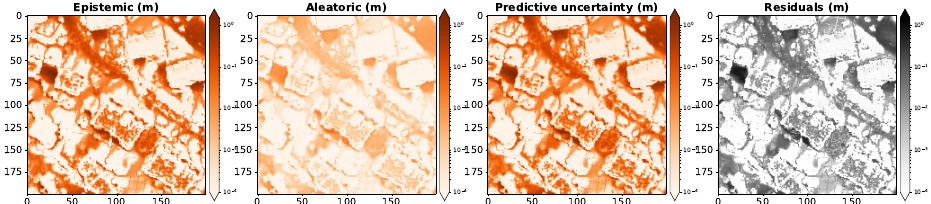
( a ) Visual comparison of epistemic, aleatoric, total predictive uncertainty, and residuals for an area of Zurich test catchment and rainfall tr2_1 .